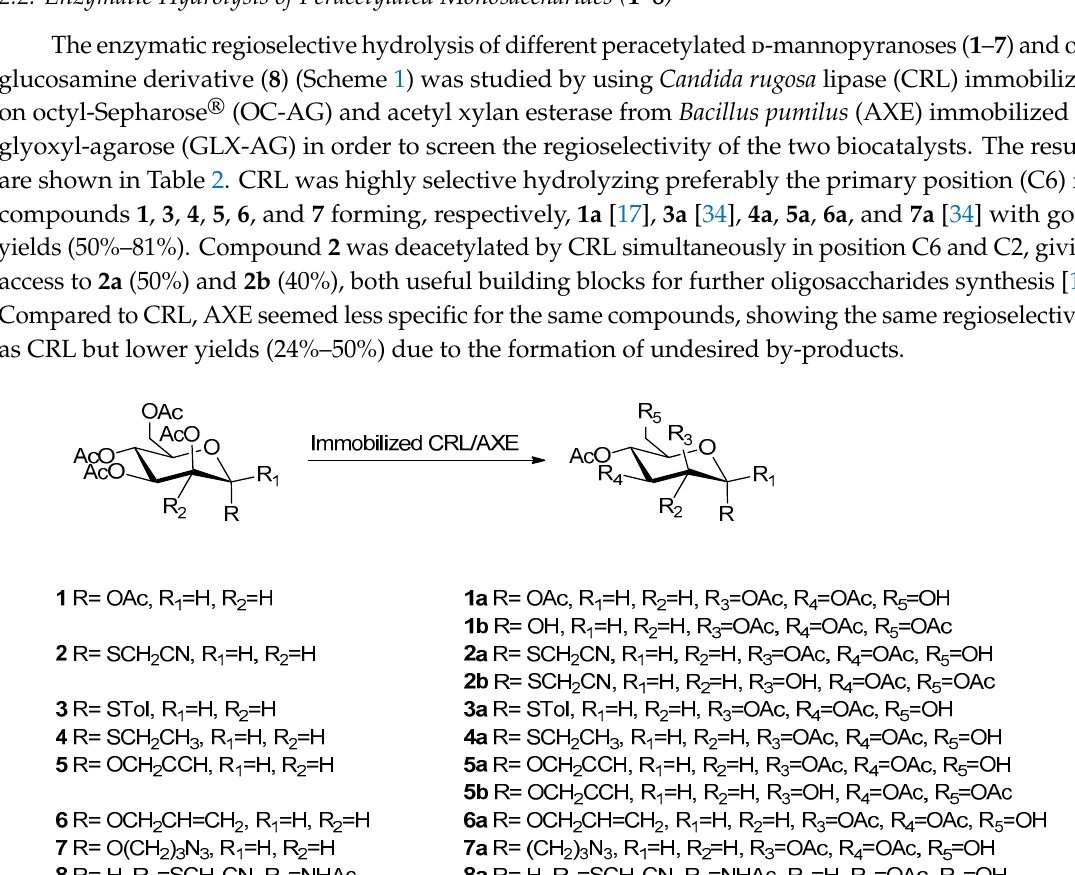
Figure 2. Stability of immobilized AXE on acrylic epoxy resin (red squares) and on glyoxyl-agarose (GLX-AG) (blue circles) in 50% acetonitrile. The measurements have been performed in duplicate.